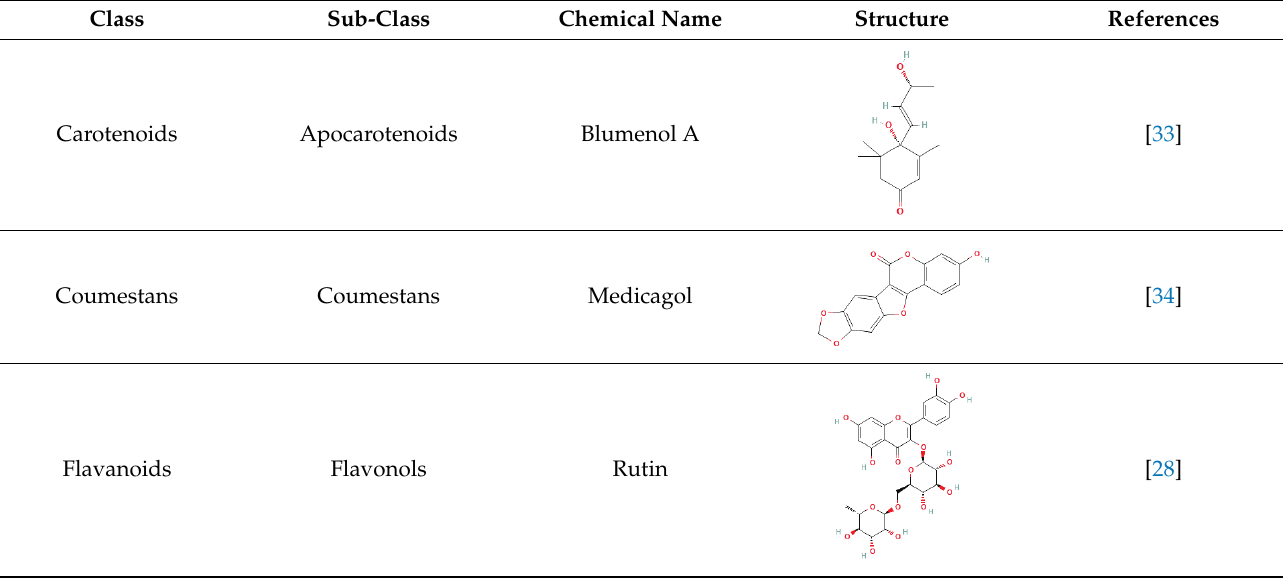
Table 1. Structure of compounds identified in SSD.